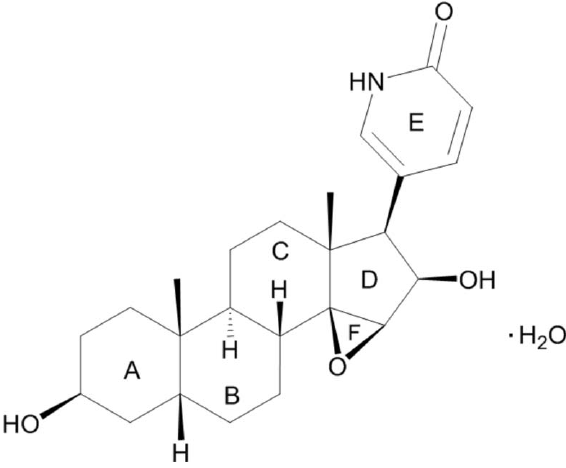
Experimental Crystal data